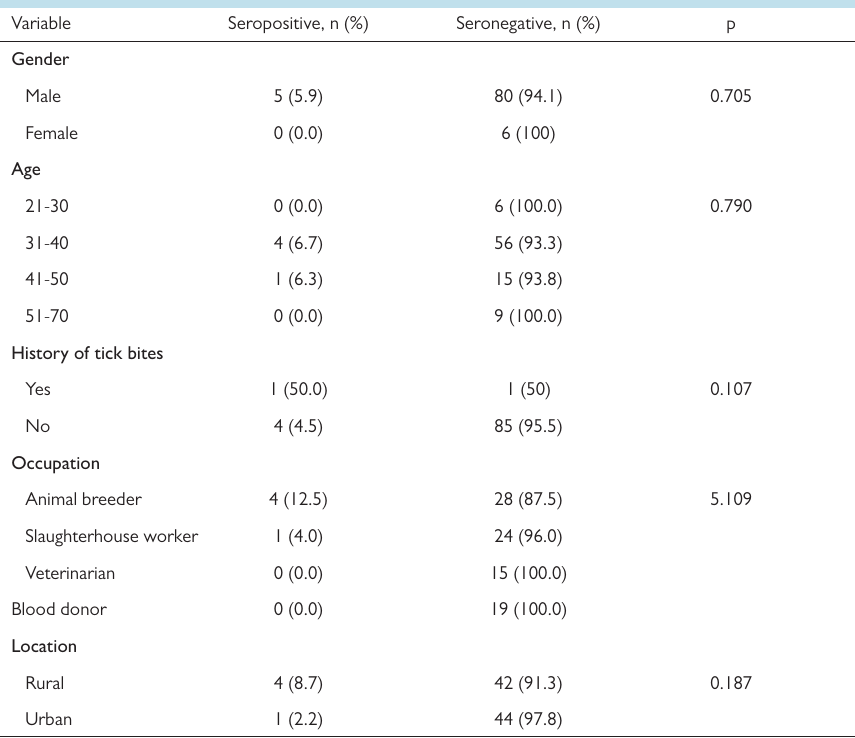
Table 1. Demographics and CCHFV seroprevalence in this study